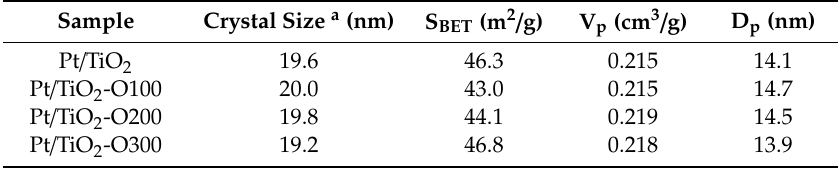
Figure 2. XRD patterns ( a ) and nitrogen adsorption/desorption isotherms ( b ) of various Pt/TiO 2 catalysts with different pre-oxidation treatments and pristine Pt/TiO 2 . The inset in ( b ) is the figure of the pore size distribution of various catalysts. Table 1. Crystal and porous structural data of various Pt/TiO 2 catalysts.